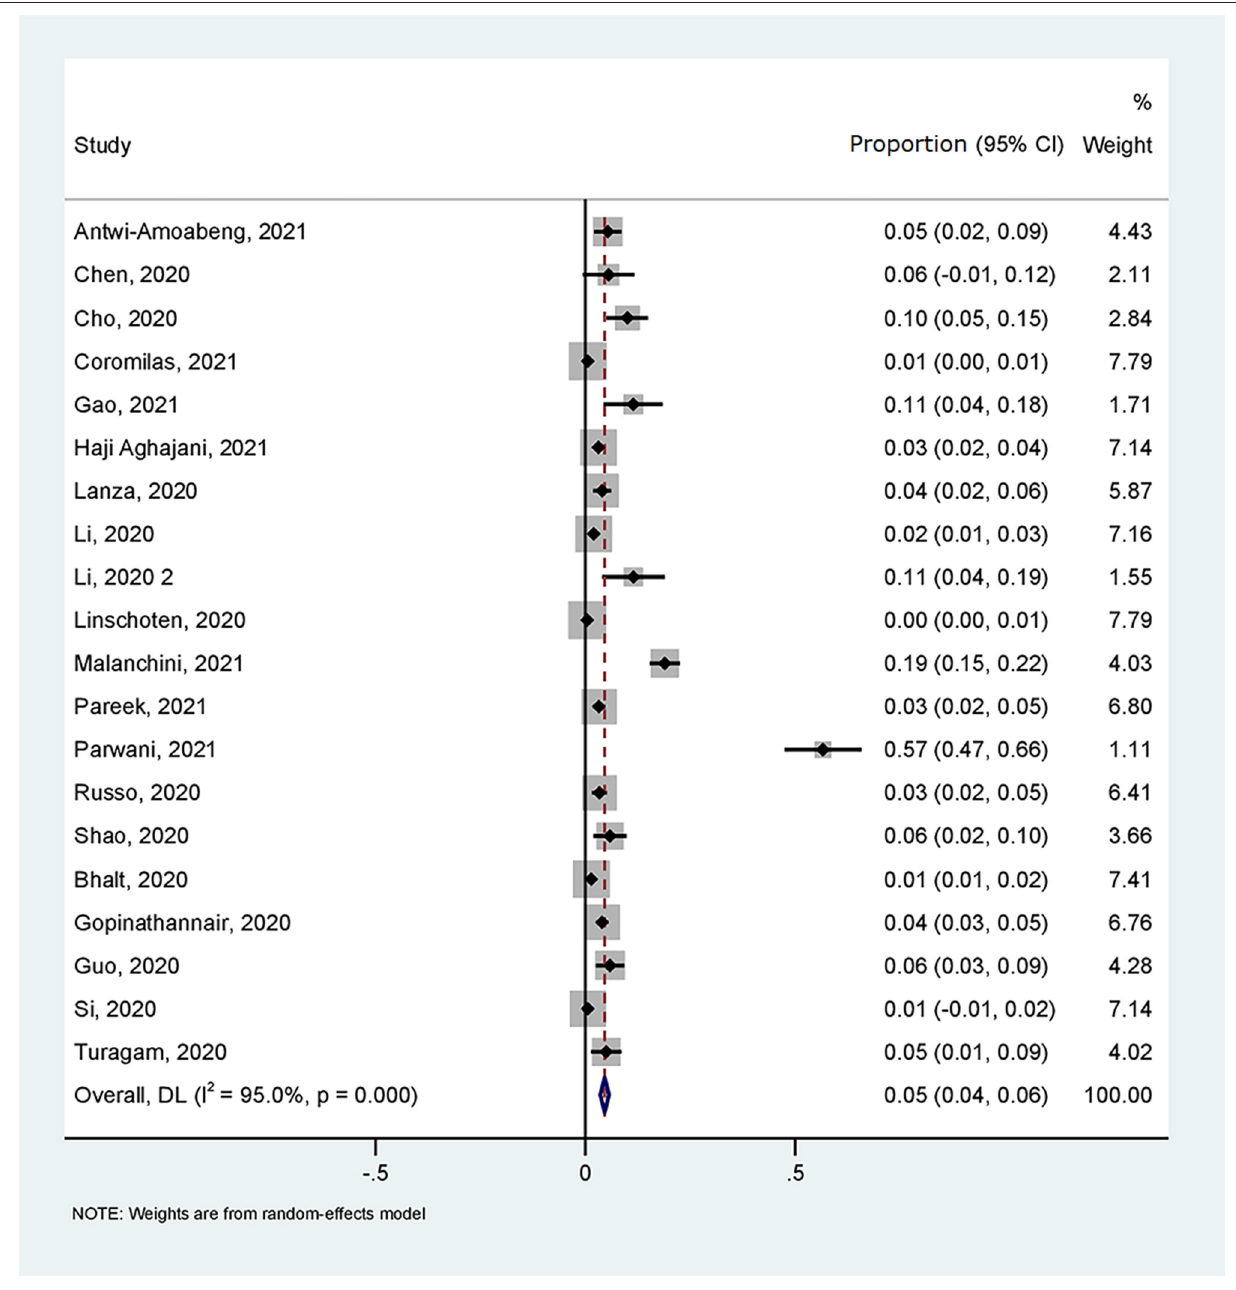
FIGURE 2 | Forest plot for the prevalence of the ventricular arrhythmia in patients with